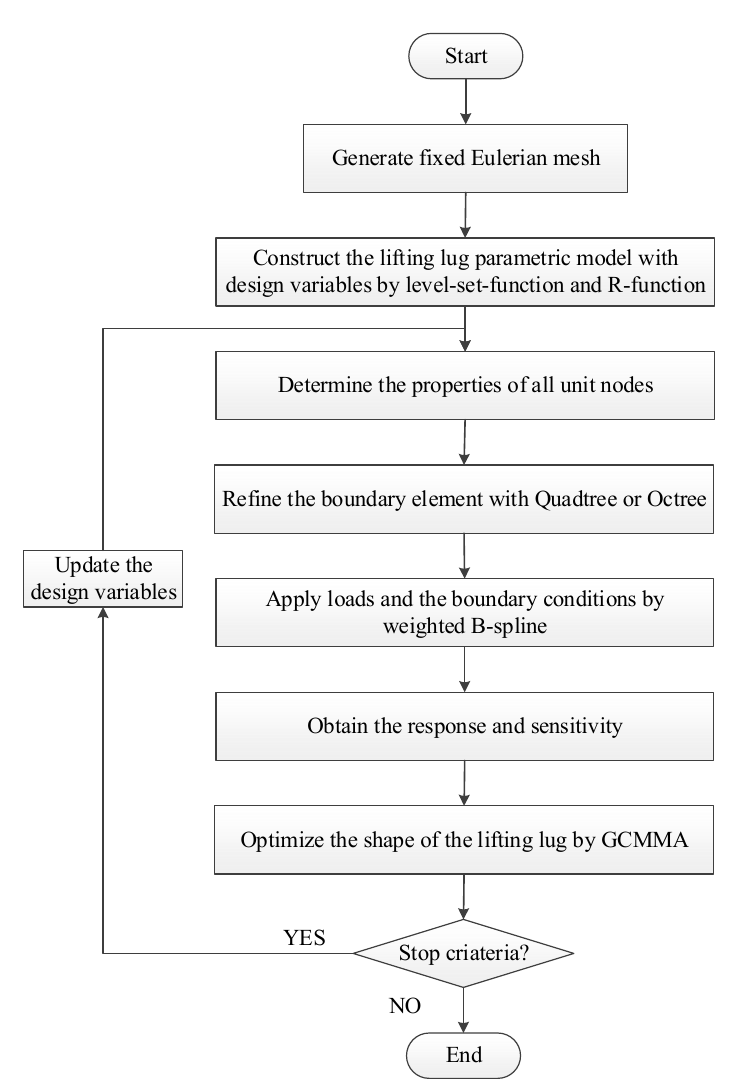
Figure 11. Flowchart of shape optimization based on the weighted B-Spline FCM and GCMMA.